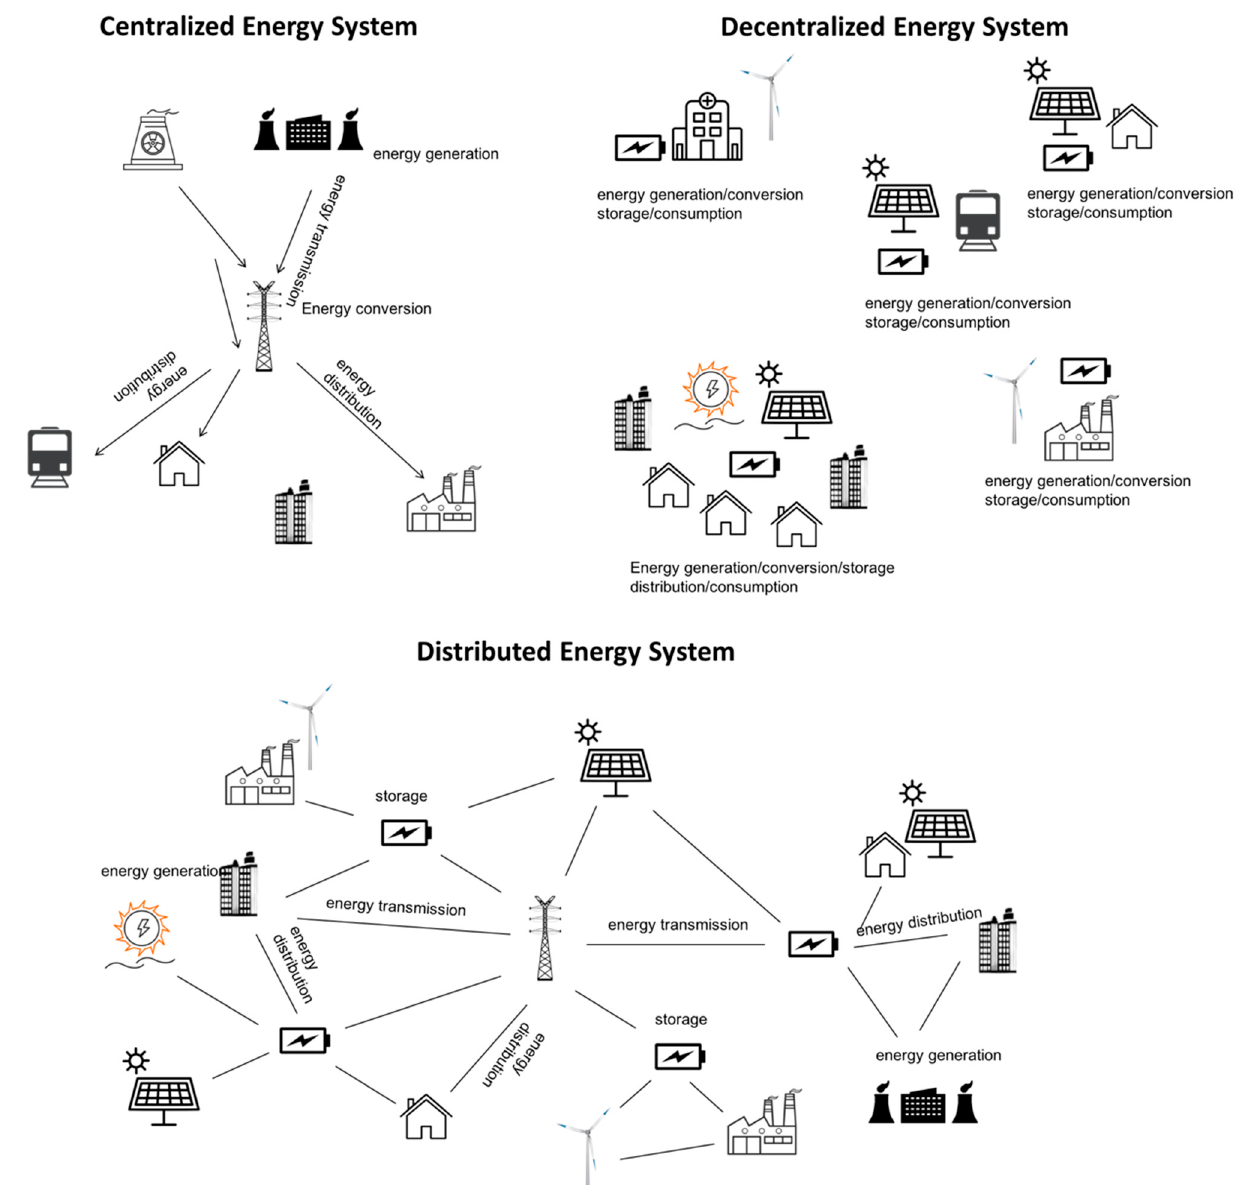
Figure 1. The Transition of Energy Systems. Modified from Alanne and Saari